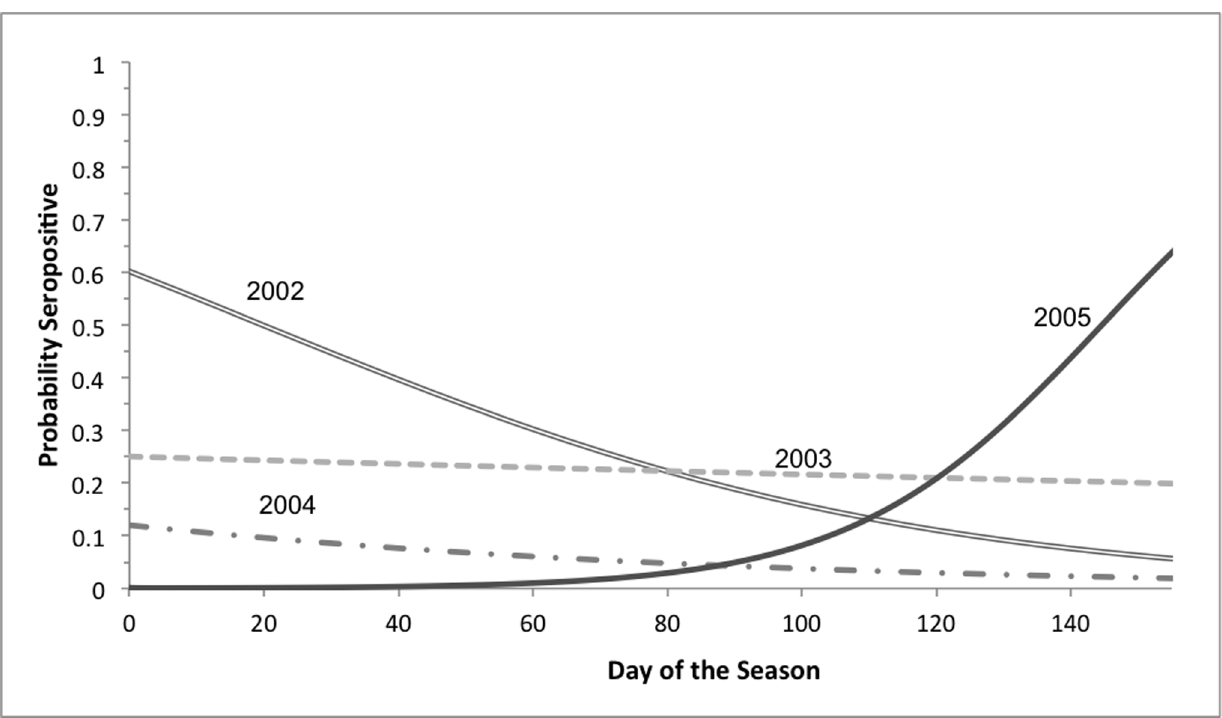
Figure 3. Relationship between day of the season (horizontal axis) and probability of an adult female big brown bat ( Eptesicus fuscus ) being seropositive for RVNA on first sampling in three different years of study. The reference year is 2003.